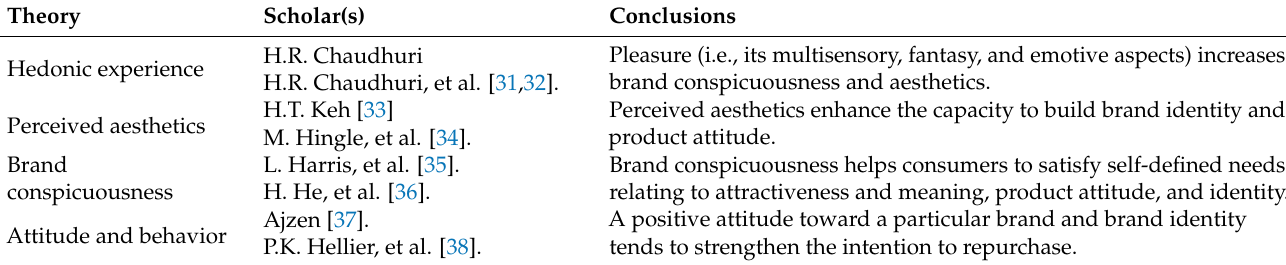
Table 1. Theoretical Background.